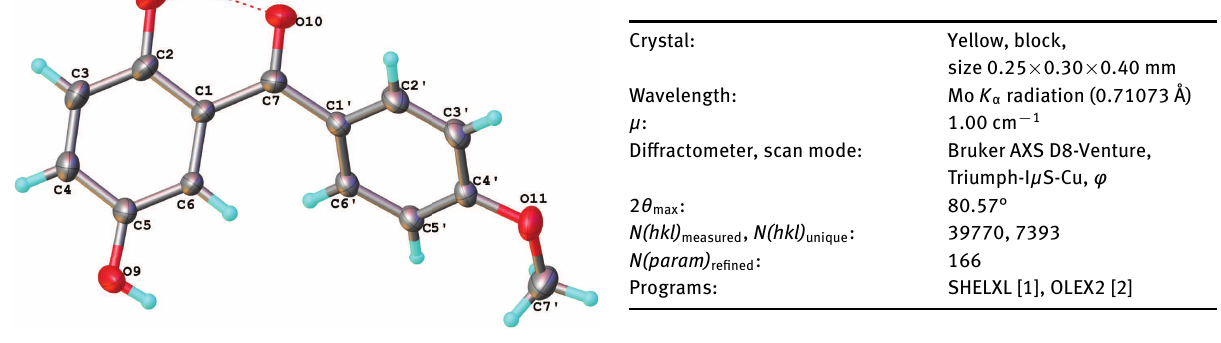
Table 2: Fractional atomic coordinates and isotropic or equivalent isotropic displacement parameters (Å 2